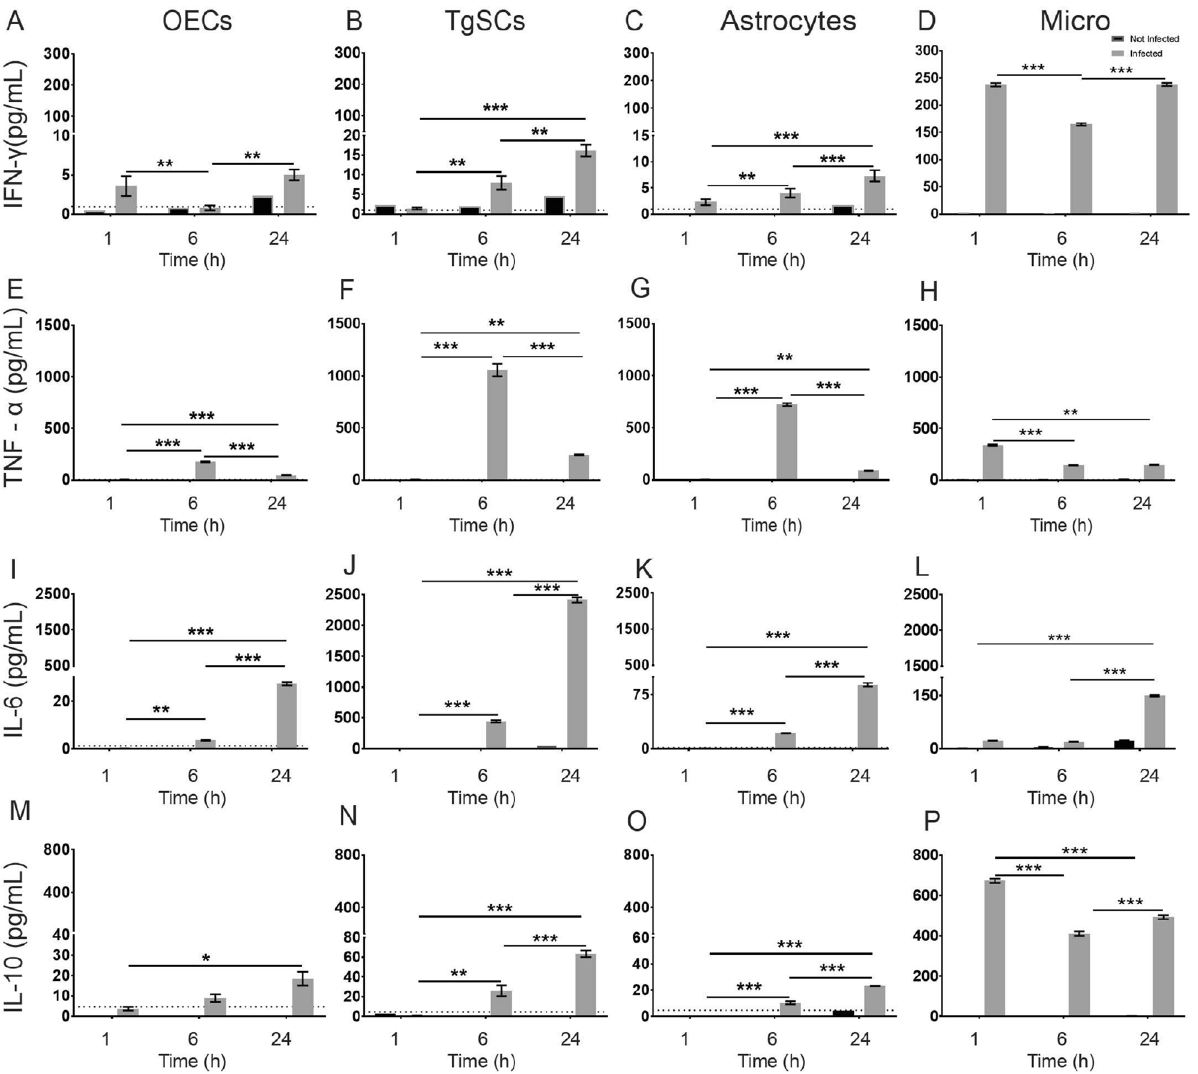
Figure 5. Cytokine responses in glia post S. aureus infection. Cytokine production by OECs, TgSCs, astrocytes and microglia were measured using multiplex ELISA at 1 h, 6 h and 24 h post exposure to S. aureus . The graphs show the amount of the pro-inflammatory cytokines IFN-γ ( A – D ), TNF-α ( E – H ), and IL-6 ( I – L ) and regulatory cytokine IL-10 ( M – P ). Data shows mean ± SEM. (* p ≤ 0.05, ** p ≤ 0.01, *** p ≤ 0.001 (two-way